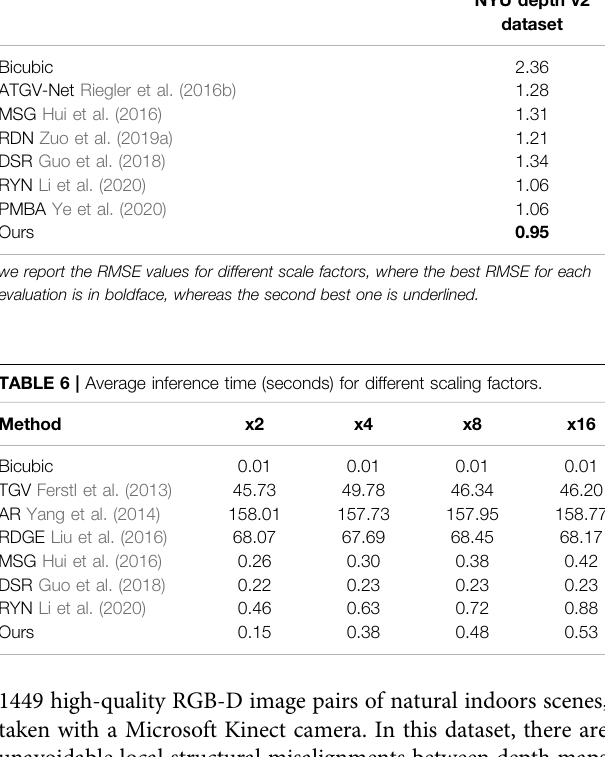
1449 high-quality RGB-D image pairs of natural indoors scenes, taken with a Microsoft Kinect camera. In this dataset, there are and color images, which may affect the performance of guided SR